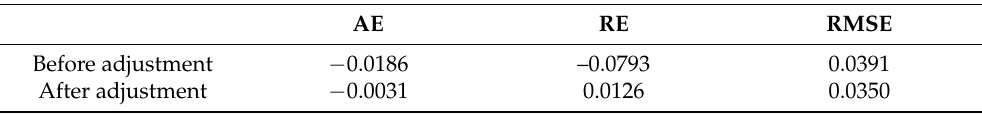
Table 2. Average values of the absolute error (AE), relative error (RE), and root-mean-square error (RMSE) before and after CDF